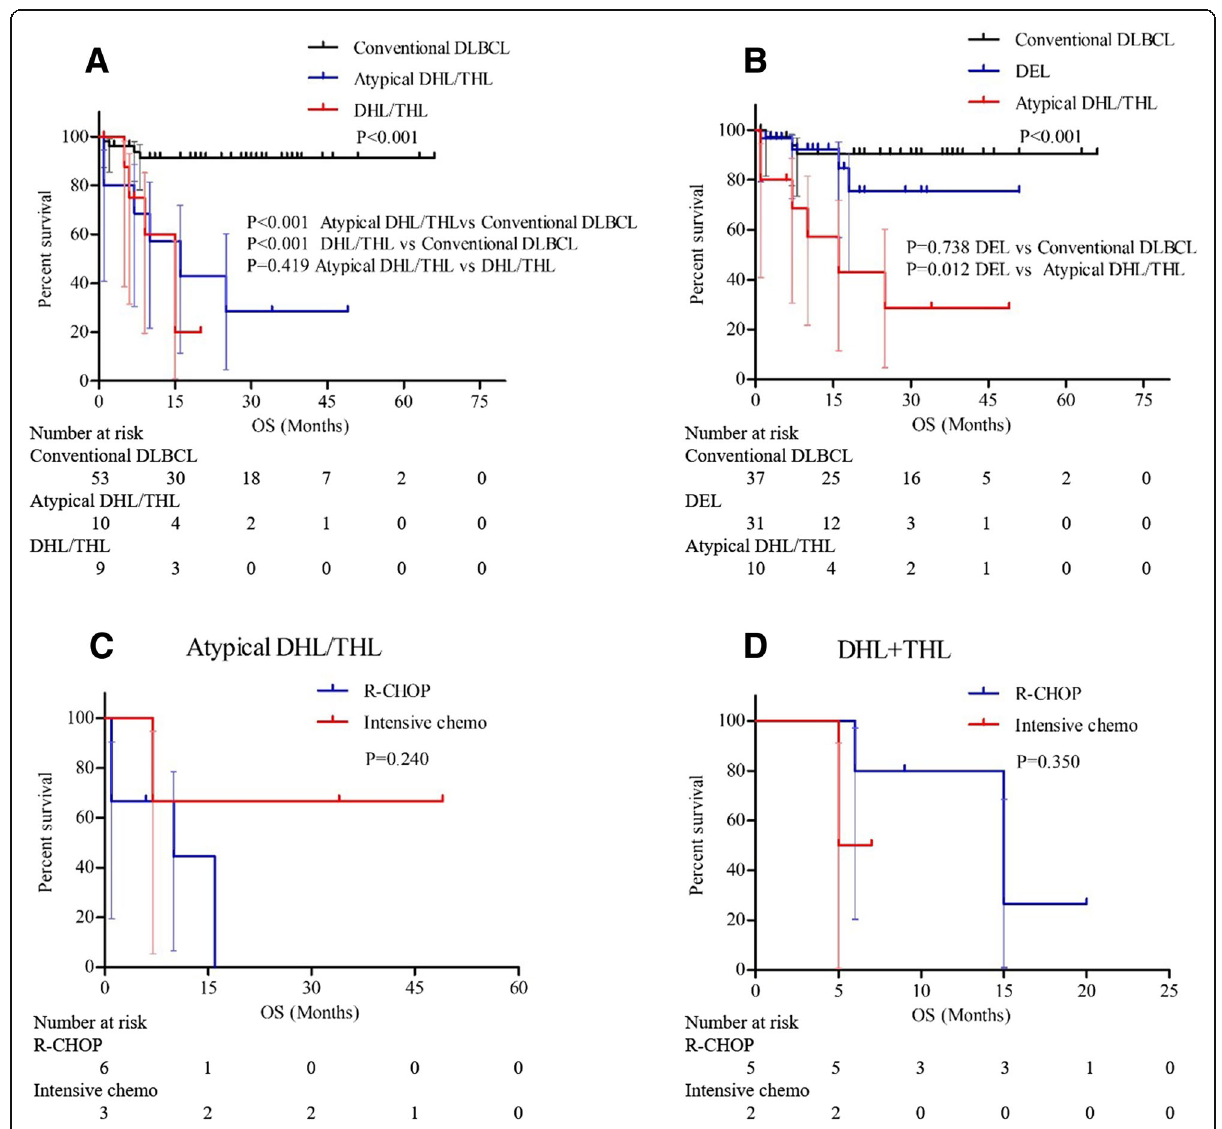
Fig. 3 Overall survival comparison between patients with atypical double-hit lymphoma (DHL)/ triple-hit lymphoma (THL) and DHL/THL or double expressor lymphoma (DEL). ( a ) patients with atypical DHL/THL vs patients with DHL/THL; ( b ) patients with atypical DHL/THL vs patients with DEL; ( c ) different induction therapy in patients with atypical DHL/THL; ( d ) different induction therapy in patients with